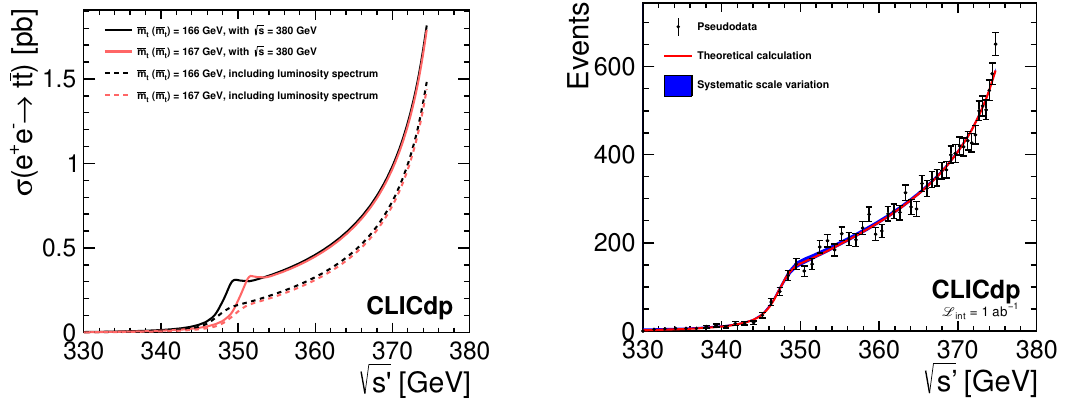
Figure 13. Prediction of the observable (left) for m the top-quark mass in the MS scheme, evaluated at the top-quark mass in the MS scheme) with the matched NNLL threshold and NNLO continuum calculation for folded with the CLIC luminosity spectrum (dashed line). Pseudodata (right) generated with the matched NNLL threshold and NNLO continuum calculation for CLIC luminosity spectrum. The markers give a statistical uncertainty estimated from the (cid:6) 1 (cid:27) envelope of 1500 datasets of 1 : 0 ab (cid:0) 1 . The shaded area gives the envelope of the scale variation presented in table